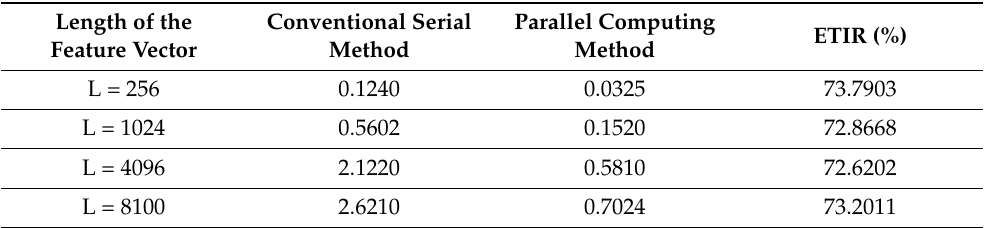
Table 2. Comparison in terms of execution time between the sequential and parallel methods for the feature vectors extraction and encryption